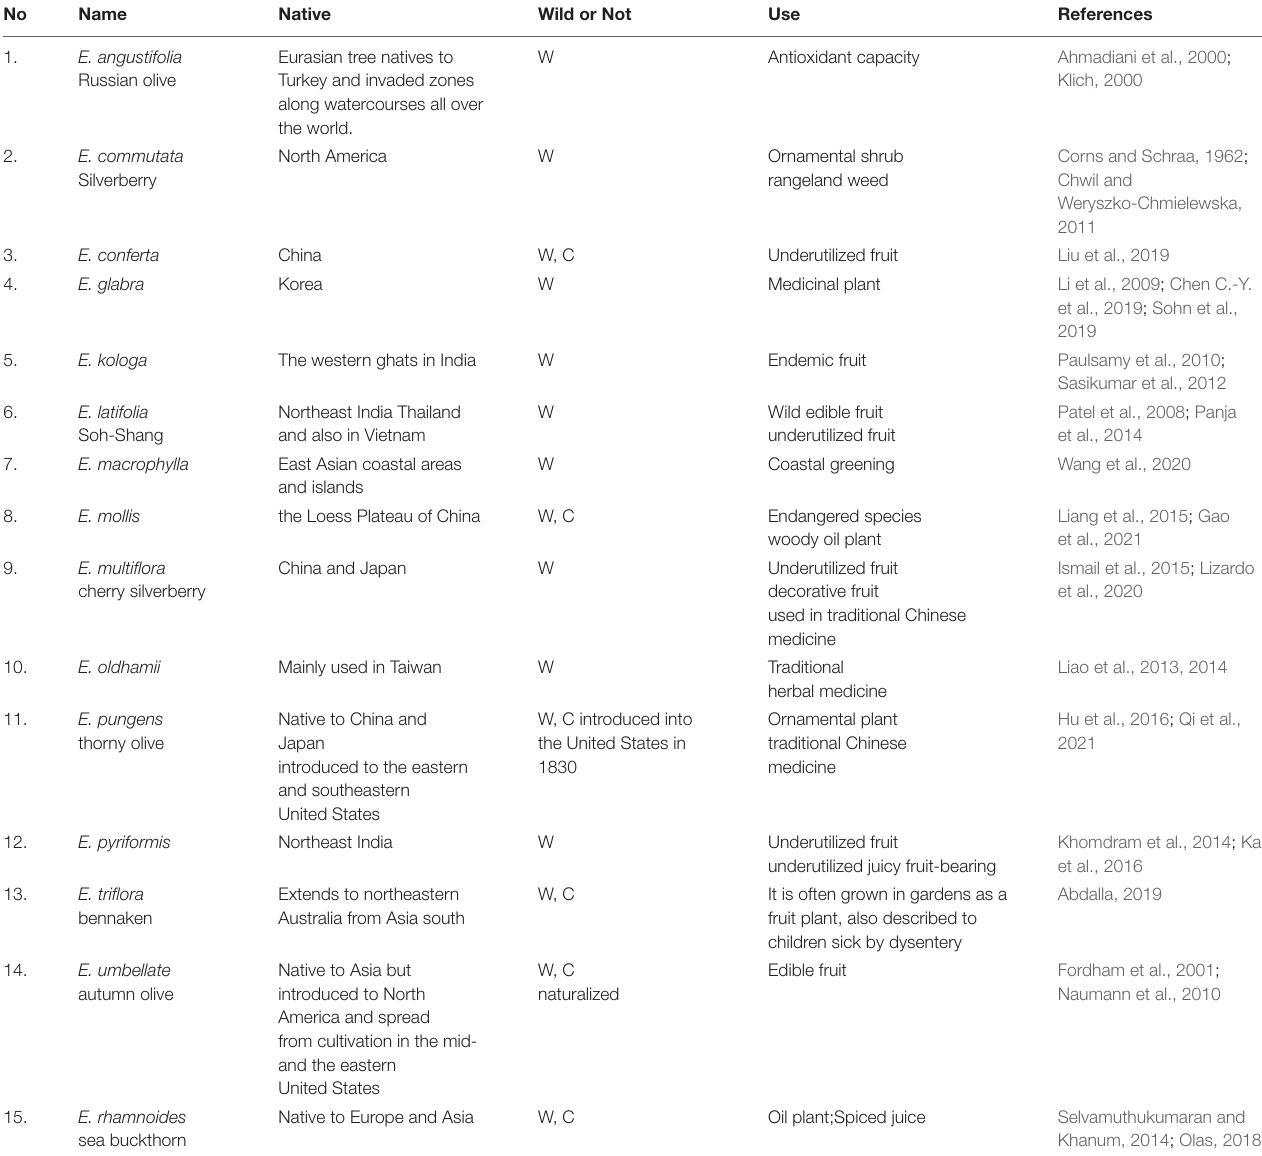
TABLE 1 | The widely reported species in Elaeagnus L. with valuable edible or medicinal